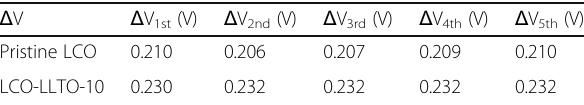
Δ V Δ V 1st (V) 2nd (V) 3rd (V)